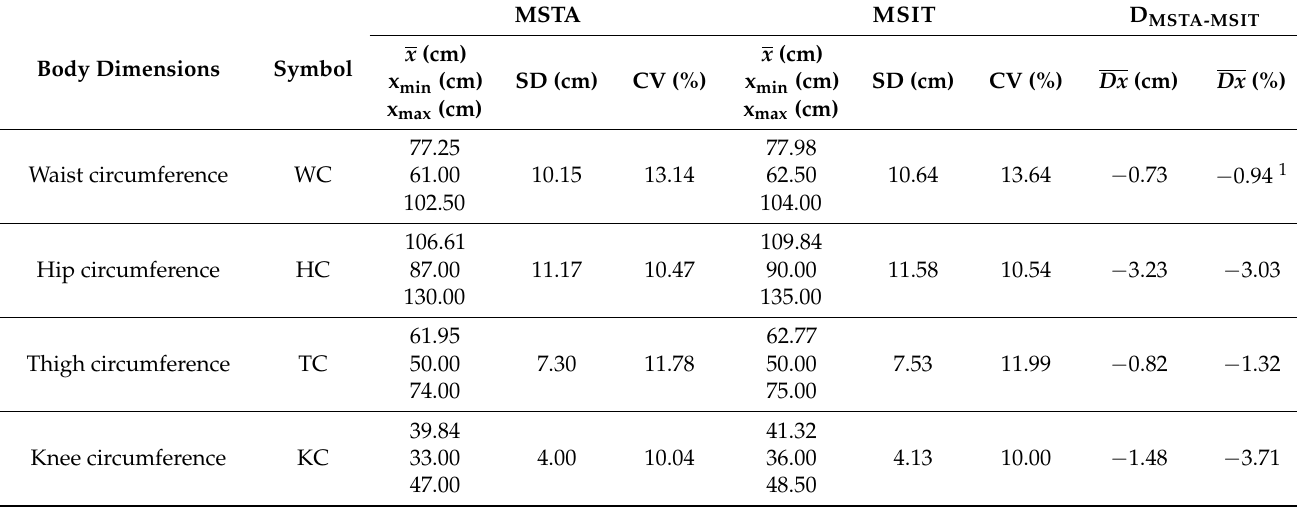
Table 5. Body measurements in standing and sitting postures and the differences between the mean values of the MSTA and